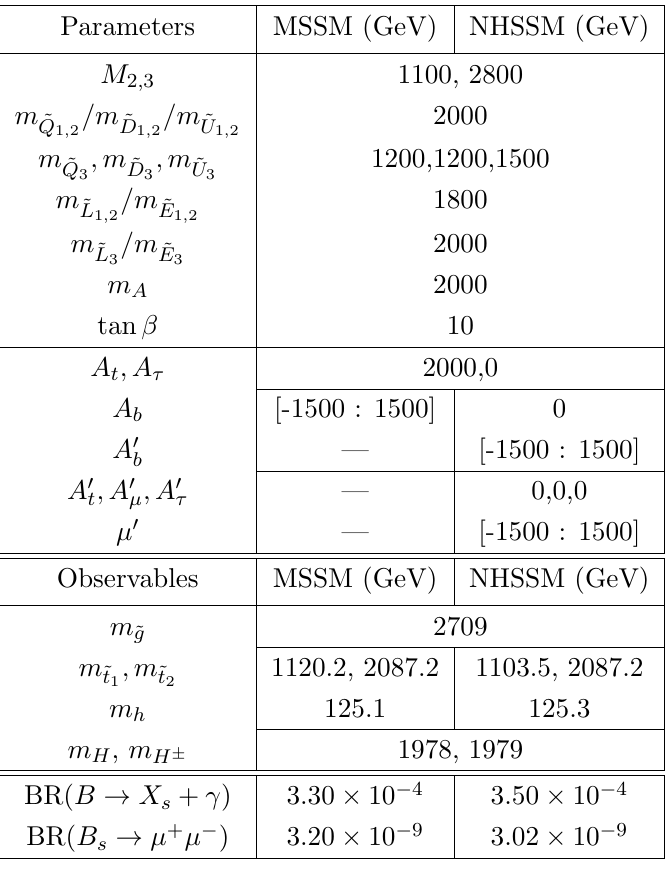
Table 1 . Fixed input parameters used in this work (unless otherwise speci(cid:12)ed) for the MSSM and the NHSSM scenarios. Values for the masses and the trilinear coupling parameters are shown in GeV. In both scenarios we set (cid:22) = 200 GeV (900 GeV) to ensure a higgsino (gaugino)-like neutralino LSP. Chosen values of tan (cid:12) , M 1 and M 2 are indicated in the text in individual contexts. SARAH (v4.10.2) -generated SPheno (v4.0.3) has been used to generate the particle spectra and for